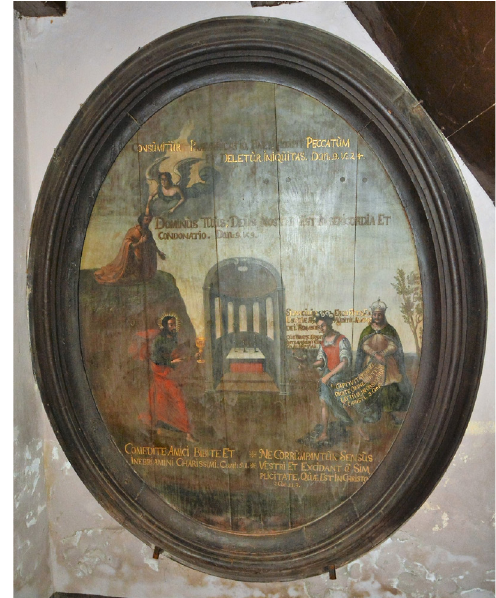
Figure 10 The spiritual freedom of